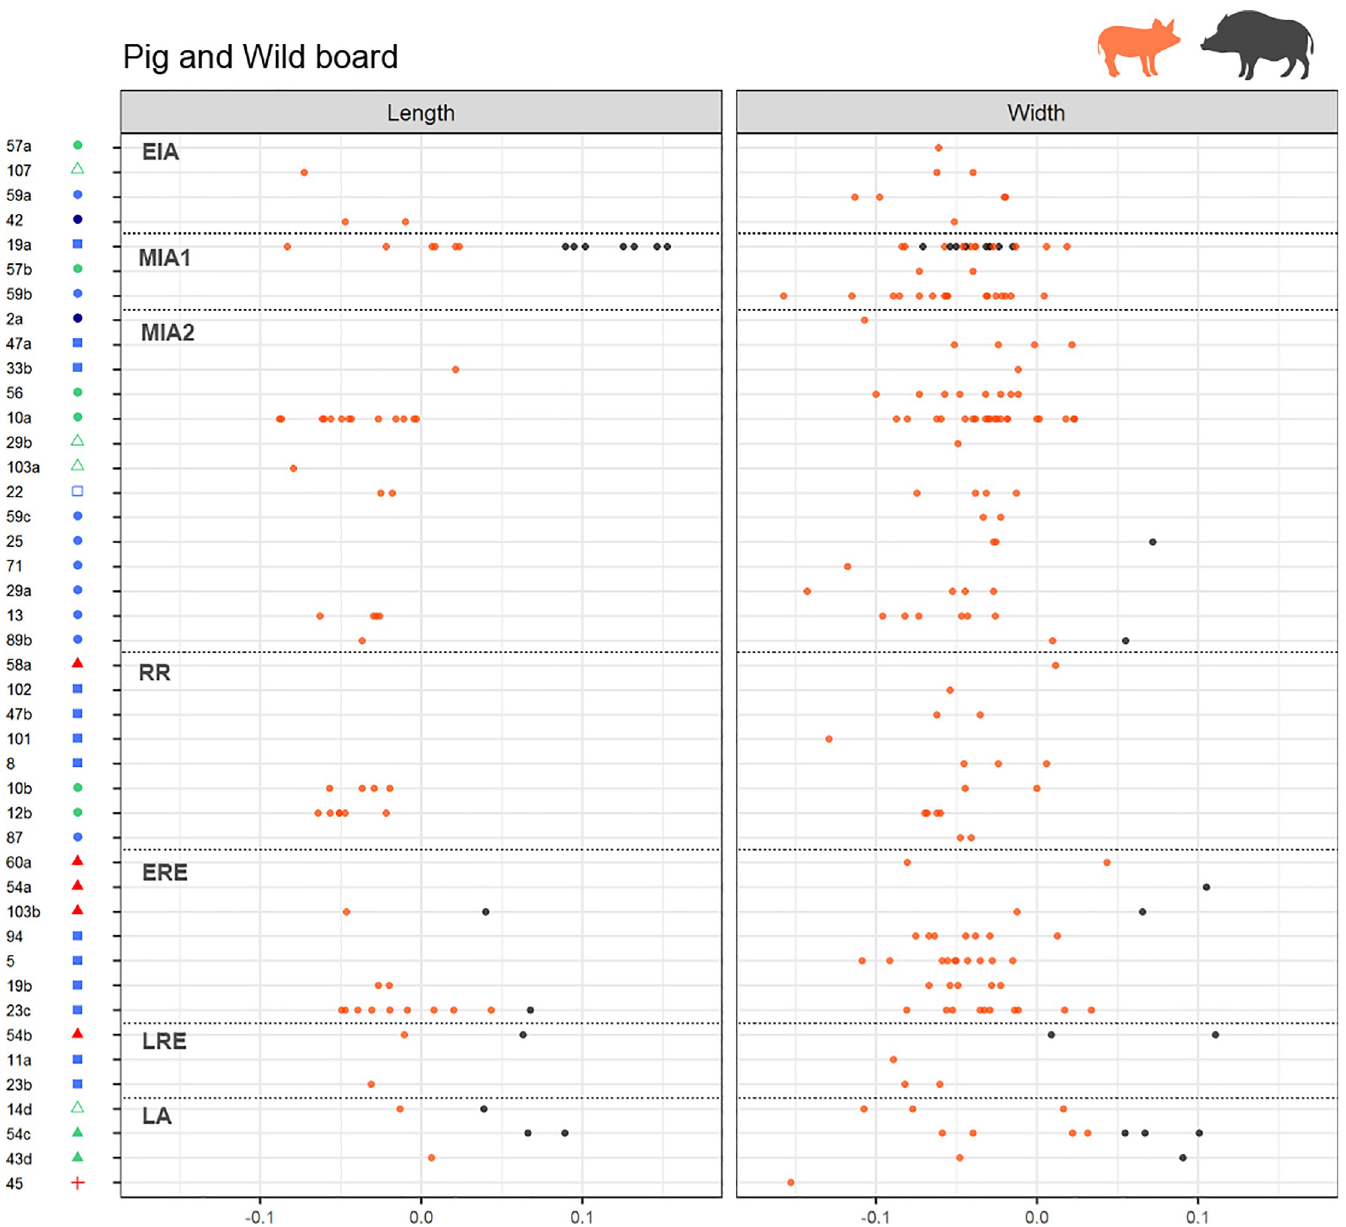
Fig 11. Pigs LSI length and width values by assemblages ordered by periods. (from top to bottom, EIA: Early Iron Age, MIA1: Middle Iron Age 1, MIA2: Middle Iron Age 2, RR: Roman Republic, ERE: Early Roman Empire, LRE: Late Roman Empire, LA: Late Antiquity). Left column shows length LSI values, right column shows width LSI values. Assemblages’ symbols refer to their type (see Fig